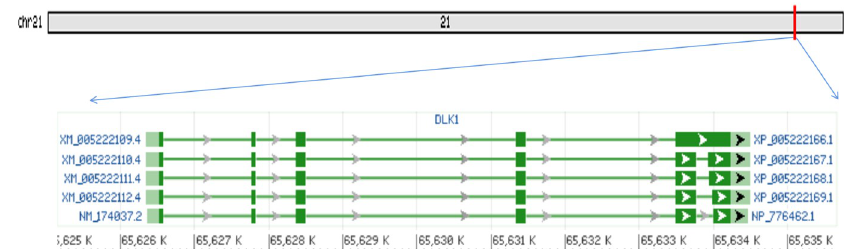
Figure 1. Five variable splicing forms of the bovine DLK1 gene and all four variable splicings are triggered by deleting the last exon partial nucleotide.